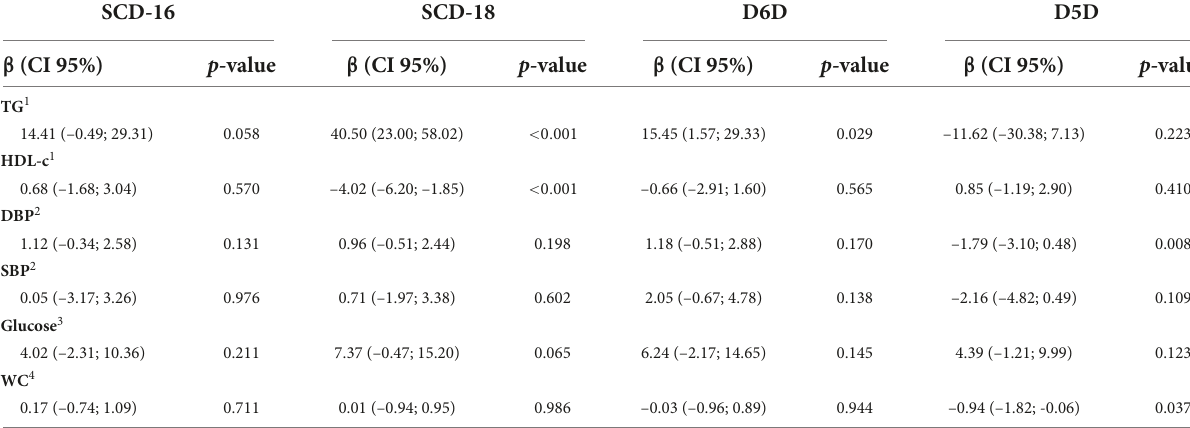
TABLE 4 Multivariable-adjusted regression for estimated DEA per 1-SD increase and MetS components at baseline. SCD-16